Question: From the figure, is the trend upward or downward?
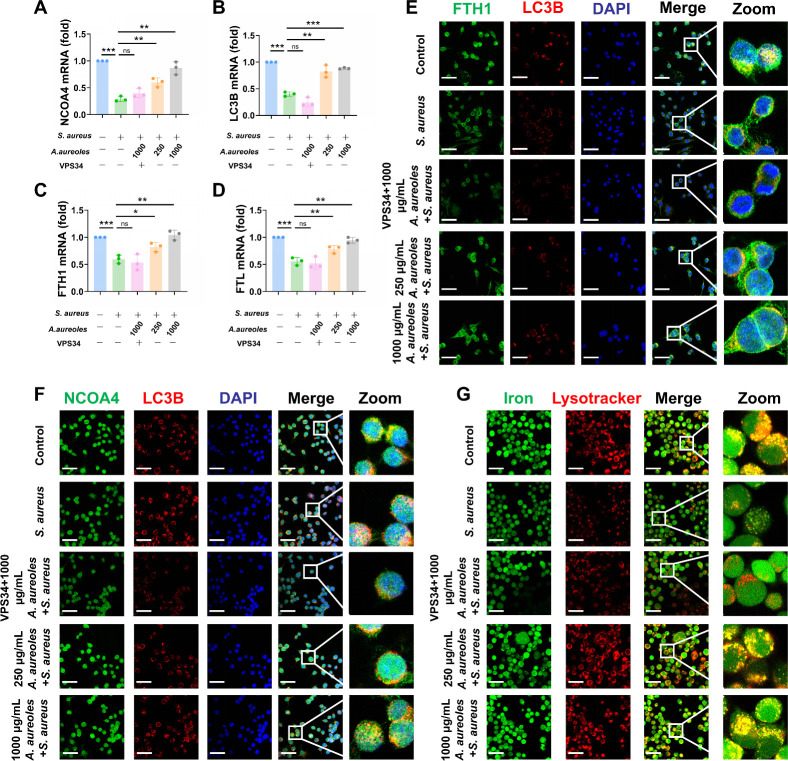
Answer: increasing